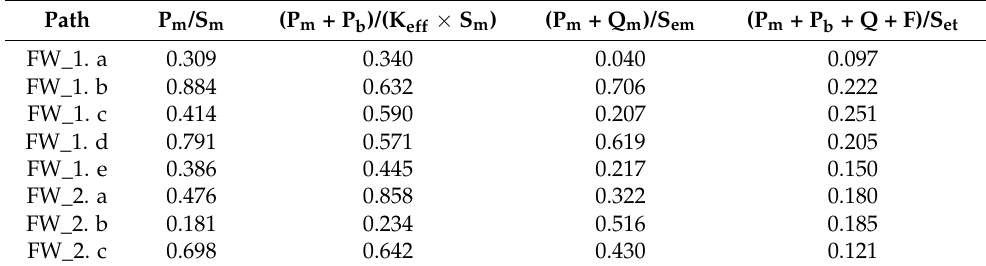
Table 2. RCC-MRx Level D criteria verification within FW-SWs